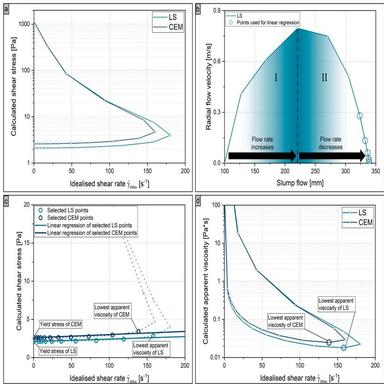
(a) Flow curve of the LS and the CEM mix, with an idealised shear rate based on 30 fps (b) Depiction of flow velocity development during the slump flow process, categorised into zones of increasing and decreasing flow rates (c) A focused representation of the flow curve involving linear regression (with a fixed intercept at yield stress) of selected measuring points between yield stress and lowest apparent viscosity (d) Viscosity curve of the LS and CEM mixes.